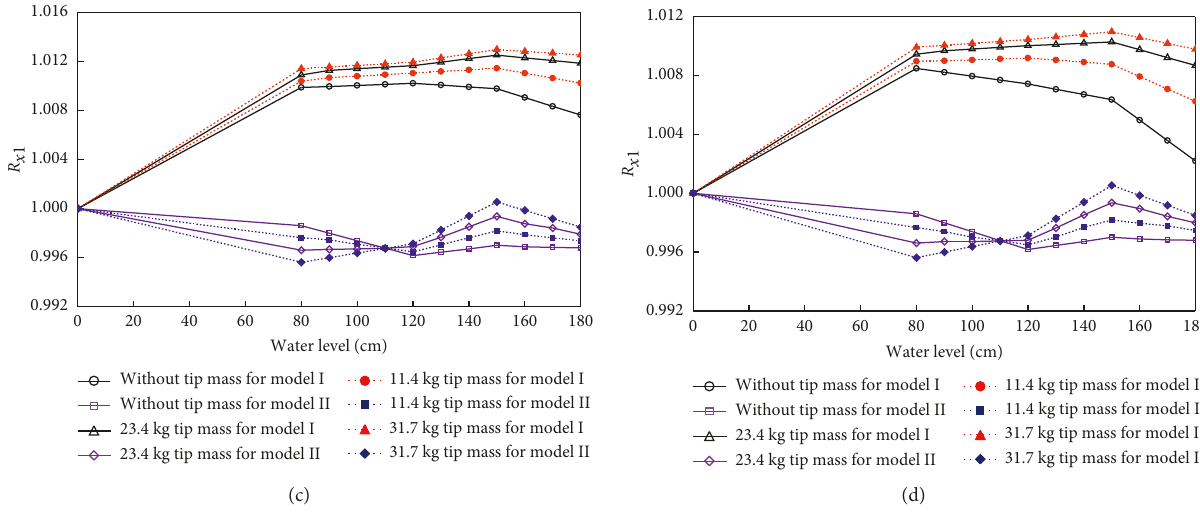
Figure 19: Vibration period ratios of the specimen in case II as a function of water level correspond to: (a) first mode along the x -axis; (b) first mode along the y -axis; (c) second mode along the x -axis; and (d) second mode along the y -axis.